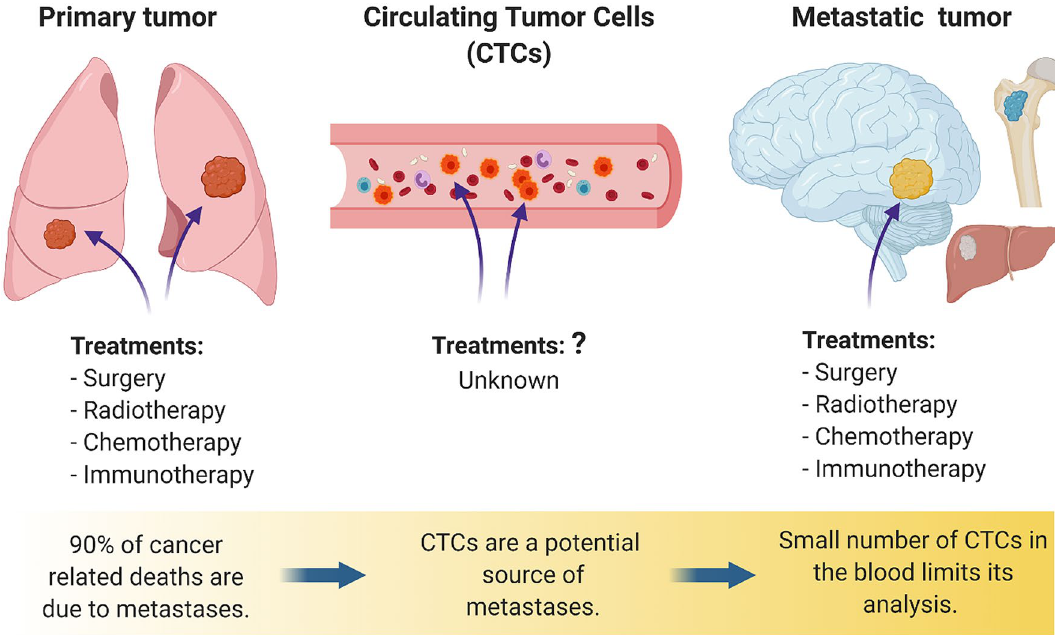
Figure 1. The cellular biology of cancer cells in circulation is poorly understood, hindering the development of efficient therapies. The majority of current treatments are aimed at treating the primary tumor or their metastatic deposits. There is little known about the treatment of cells in circulation, which are also called circulating tumor cells (CTCs). It remains unclear how some cells within the primary tumor can survive prolonged circulation to develop metastatic